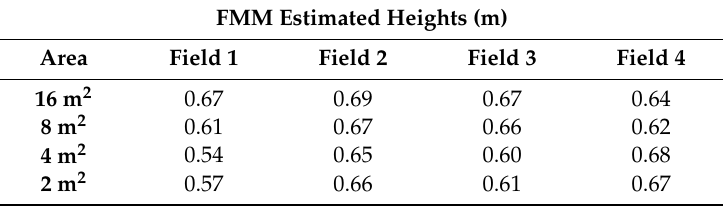
Table 2. Heights estimated from soybean fields using image subsample sizes of four, eight, and sixteen square meters.